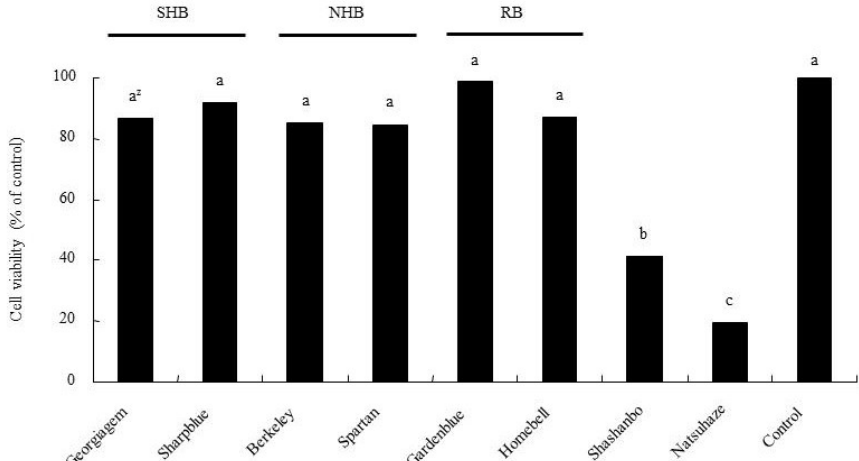
Figure 5. Effect of ethanol extracts on the viability of HL-60 cells.